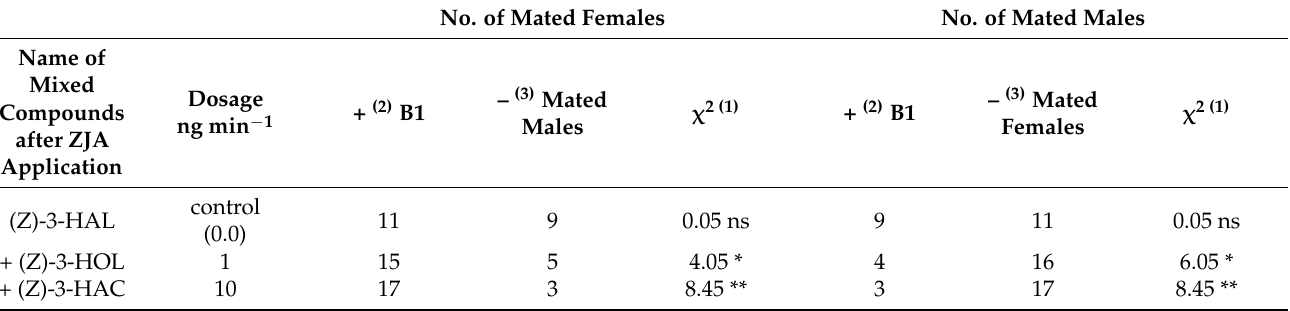
Table 6. The effect of a synthetic blend of three GLVs (blend B1) on mated beetles and on the number of A. miniatum adult females and males choosing to enter a Y-tube arm containing the blend odor or the control Y-tube arm containing purified, humidified air and hexane solvent (no odor). Only concentrations working as attractants (see Tables 1 and 2) were used.